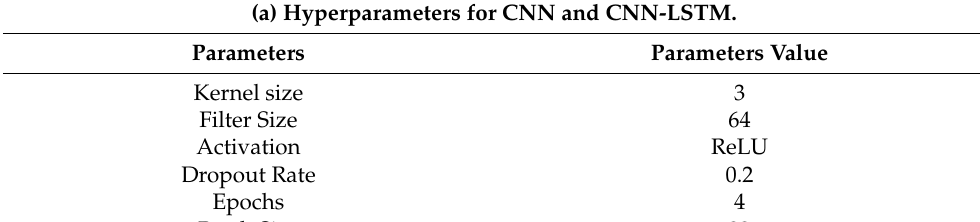
Table 11. Optimized hyperparameters adapted for CNN, LSTM, Bi-LSTM, and CNN-LSTM. (a) Hyperparameters for CNN and CNN-LSTM.